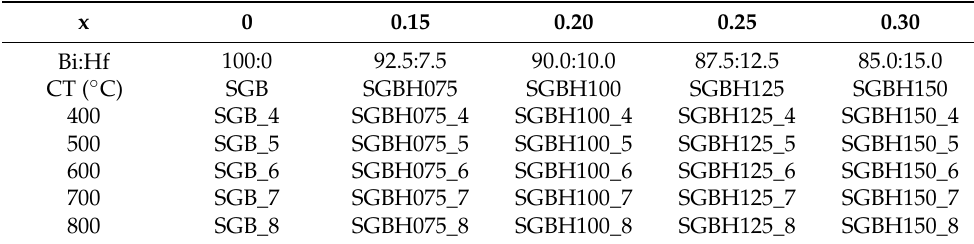
Table 1. Sample codes for the sol-gelled Bi 2-x Hf x O 3+x/2 composite powders calcined at various temperatures for 1 h (CT: calcination